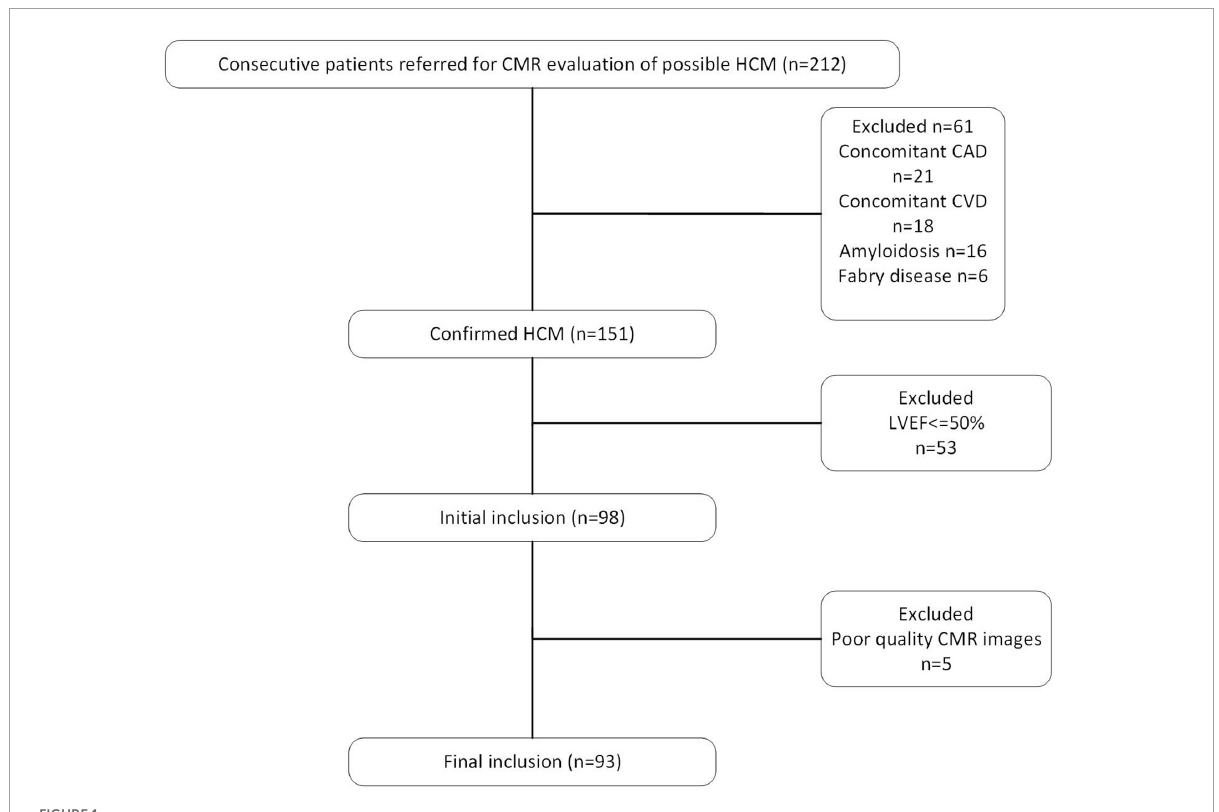
FIGURE1 The flowchart of inclusion and exclusion criteria.